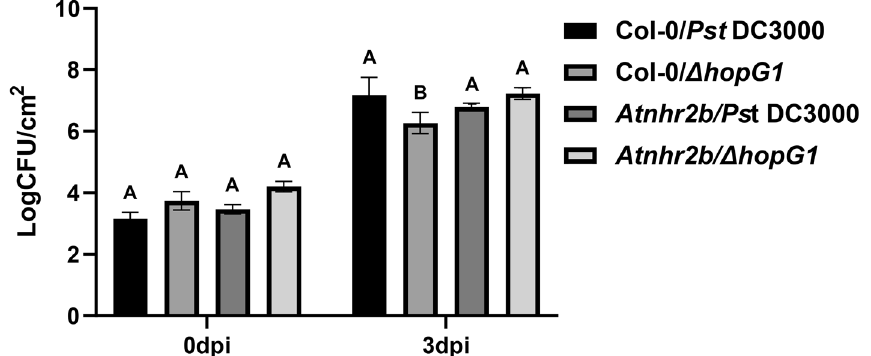
Figure 2. The growth defect in Pst DC3000 hopG1 deletion mutant is restored in Atnhr2b mutant Arabidopsis plants. Wild-type Col-0 and the Atnhr2b mutant were syringe-inoculated with the wild-type Pst DC3000 and the Pst DC3000 Δ hopG1 mutant at a concentration of 1 × 10 4 CFU/ml. Inoculated leaves were collected at 0 and 3 dpi to enumerate bacterial populations. Bars represent means and standard deviation for Pst DC3000 and Δ hopG1 bacterial populations in Col-0 and Atnhr2b plants for four replications. Different letters above the bars represent statistically significant difference in bacterial populations of wild-type Pst DC3000 and the Pst DC3000 Δ hopG1 in Col-0 versus their respective growth in the Atnhr2b mutant plants using a one-way ANOVA and Tukey’s multiple comparison test with P-value ≤ 0.05. The experiments were repeated three times with consistent